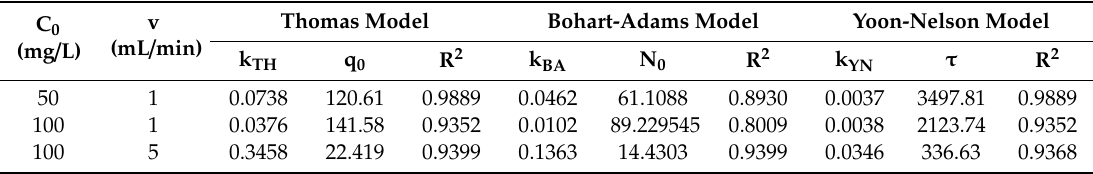
Table 4. Parameters obtained from three dynamic adsorption